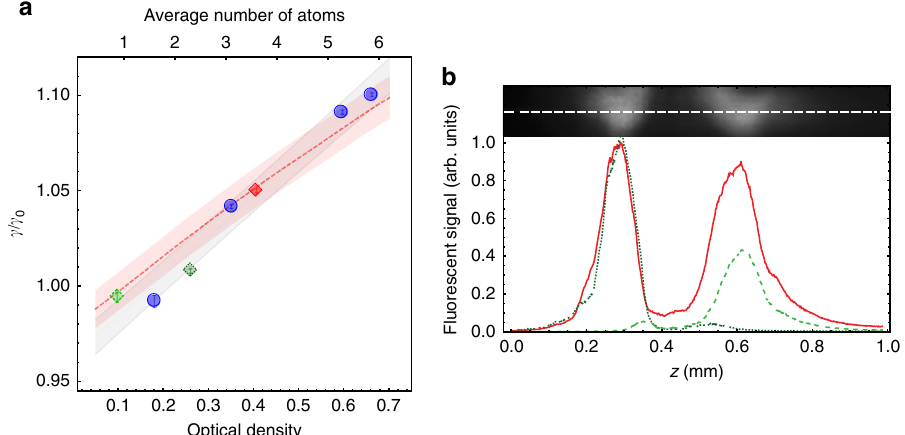
Fig. 3 Super-radiant decay as a function of atom number including separated clouds. a Relationship of the decays as a function of average number of atoms (OD) along the optical nano fi ber. The normalized fast decay rates are plotted as a function of the OD (lower abscissa) and N (upper abscissa) measured through the ONF-guided mode. The blue circles correspond to the signals from a single cloud of atoms. We split the atomic cloud in two (as shown in b ). The dashed light and dotted dark green diamonds, and the solid red square correspond to the right, left, and the combination of both atomic clouds, respectively. The systematic errors (not shown) are estimated to be 1% for the decay rates and smaller than 20% for the atom number. The plotted error bars represent the statistical uncertainty of the fi tting to an exponential decay. The gray region represents the one-sigma con fi dence band of a linear fi t to the data. The red dashed line is the theoretical prediction, and the red shaded region represents a con fi dence interval set by a fractional error of 1%. The curve goes below γ / γ 0 = 1 because the natural decay rate is modi fi ed given the geometry of the ONF and the alignment of the atomic dipoles (Purcell effect) 36 . b Separated atom clouds show long-range interactions. The top of the fi gure shows in black and white a fl uorescence image of a split MOT. The white dotted line represents the ONF location. The fl uorescence signal of the split MOT along the nano fi ber is plotted as a function of position. The dashed light (dotted dark) green dashed lines is the intensity distribution of the right (left) atomic cloud when the other one is blocked. The solid red line is the intensity distribution when both clouds are present. The separation between the center of both clouds is 318 ± 1 μ m, given by standard error of the mean of a Gaussian fi t. This distance is equivalent to 408